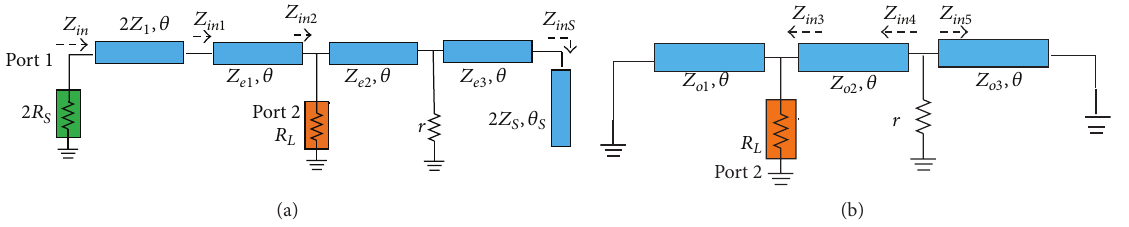
Figure 2: Simplified equivalent circuit of the proposed power divider under (a) even- and (b) odd-mode excitations.